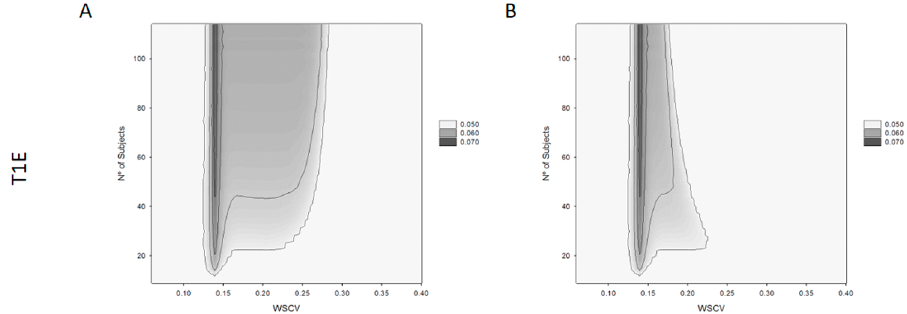
Figure 3. Type I error (T1E) for the proposed NLIVR conditions with ( B ) and without ( A ) GMR constraint for different WSCV and number of subjects.